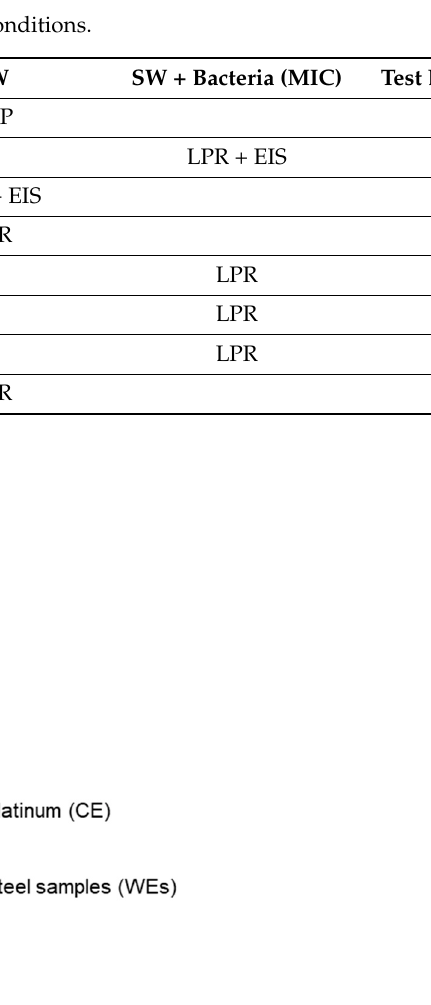
Figure 1. A typical sample exposure vessel for linear polarization resistance (LPR) and electrochemical impedance spectroscopy (EIS) measurements. Table 2. Experimental methods and conditions.